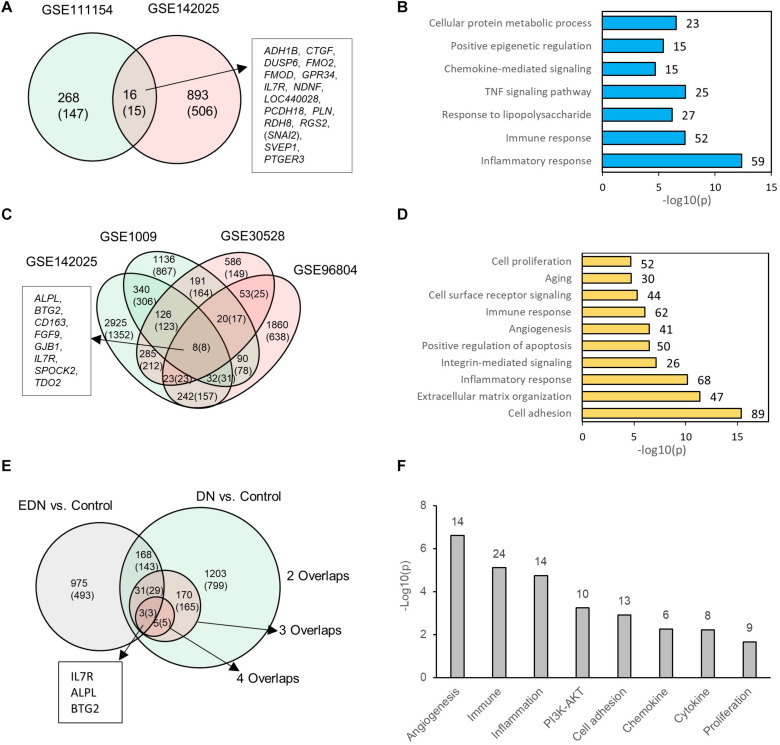
Differential expression profiles of mRNAs during EDN and DN. (A) a Venn diagram showing differentially expressed genes/mRNAs (DEGs) identified from two transcriptomic datasets of EDN. (B) Graph showing significant biological functions under EDN. (C) A Venn diagram showing DEGs identified from four transcriptomic datasets of DN. (D) Graph showing significant biological functions under DN. (E) A Venn diagram showing overlapping between EDN and DN. The “2, 3, and 4 overlaps” represents intersection of two, three, and four DN datasets, respectively. (F) Significantly enriched biological function of overlapped DEGs between EDN and DN. The number on each bar represents number of overlapped DEGs within this function category. In A, C, and E, numbers in the parentheses refer to number of DEGs with fold change at least 2.0.